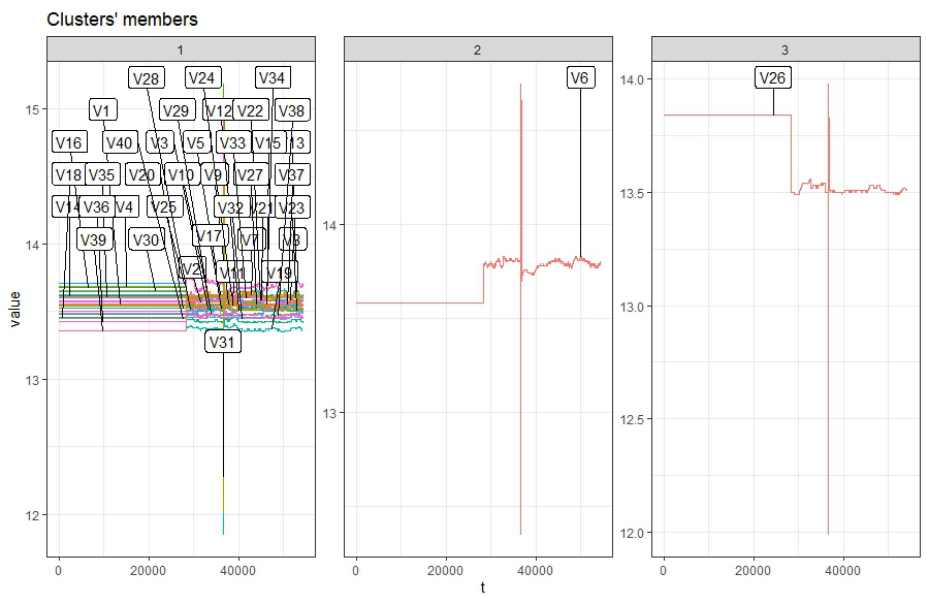
Figure 8. Dynamic Time Warping (DTW) clustering 1st month clusters.